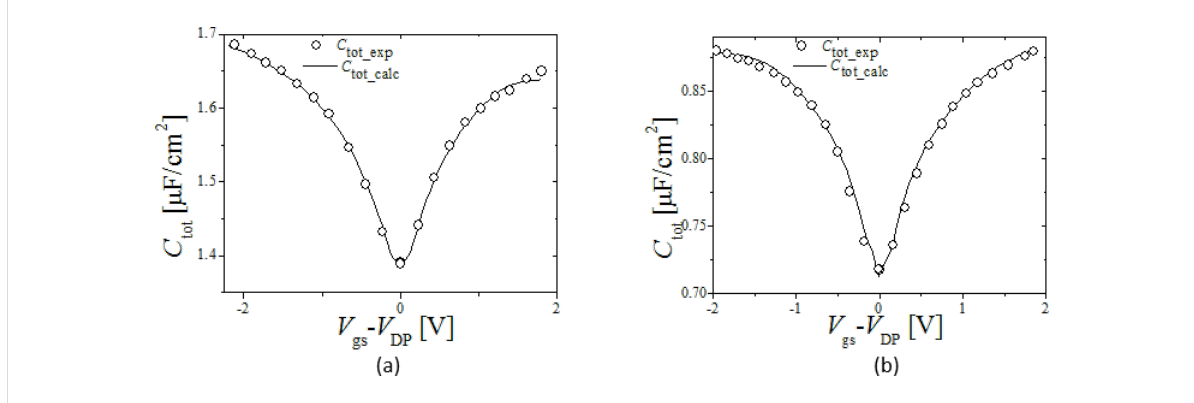
Figure 8: (a) and (b) C tot for Device 1 [7] and 2 [12] respectively, symbols: C tot_exp as a function of V gs , lines: C tot_calc from Equation 2 as a function of V gs